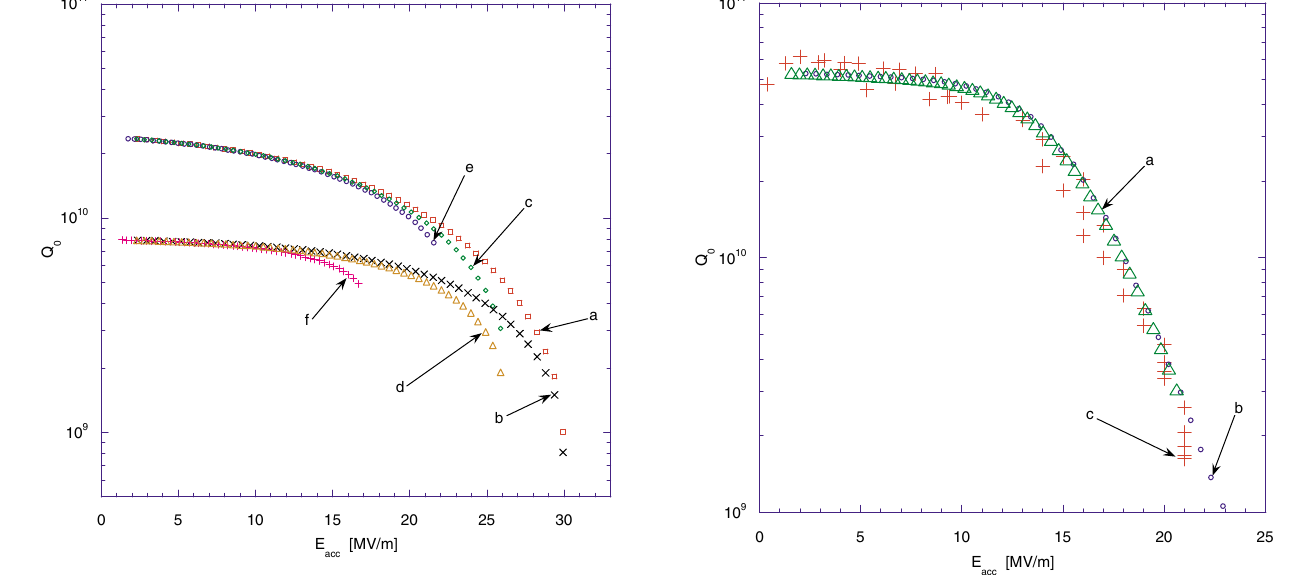
FIG. 14. (Color) Performance simulation and experimental data for a 700 MHz cavity suffering from electron field emission. ( a ) ( 4 ) pipe cooled simulation; ( b ) (o) bath cooled simulation; ( c ) (+) measured